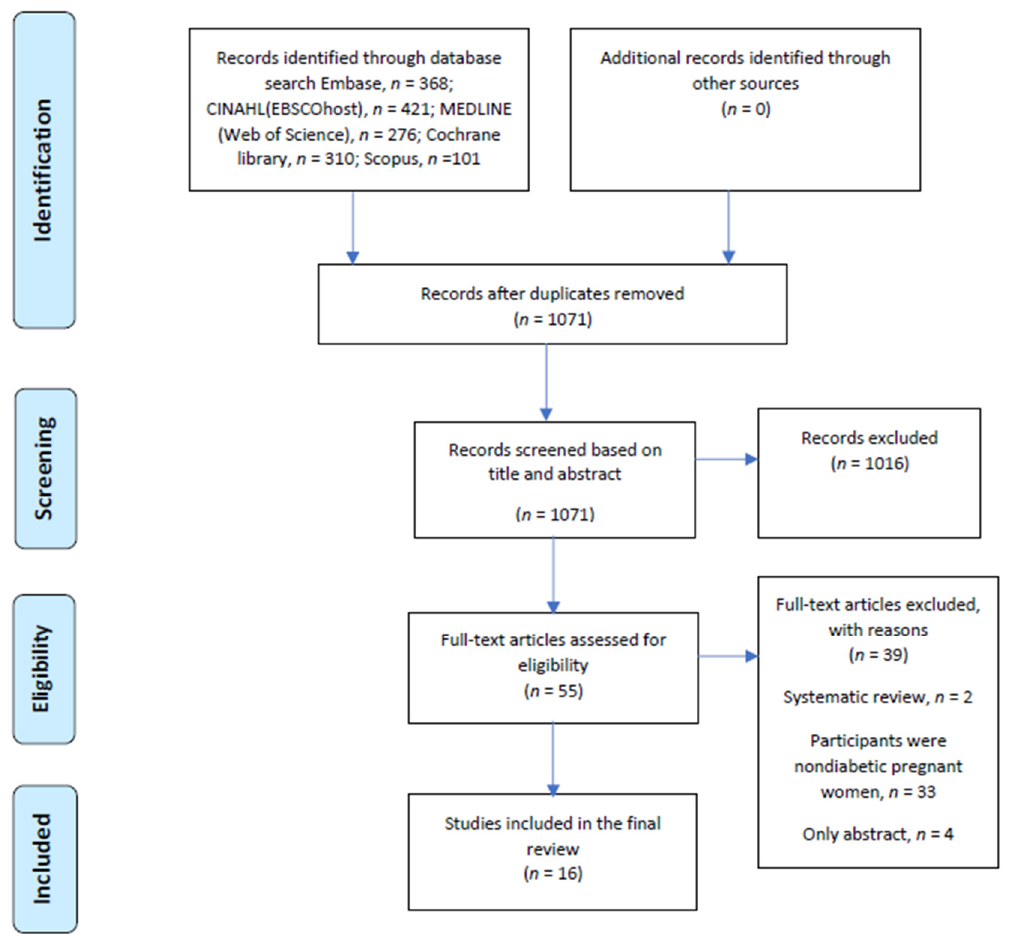
Figure 1. Preferred Reporting Items for Systematic Reviews and Meta-Analyses (PRISMA) flow diagram for the search strategy and study selection process.